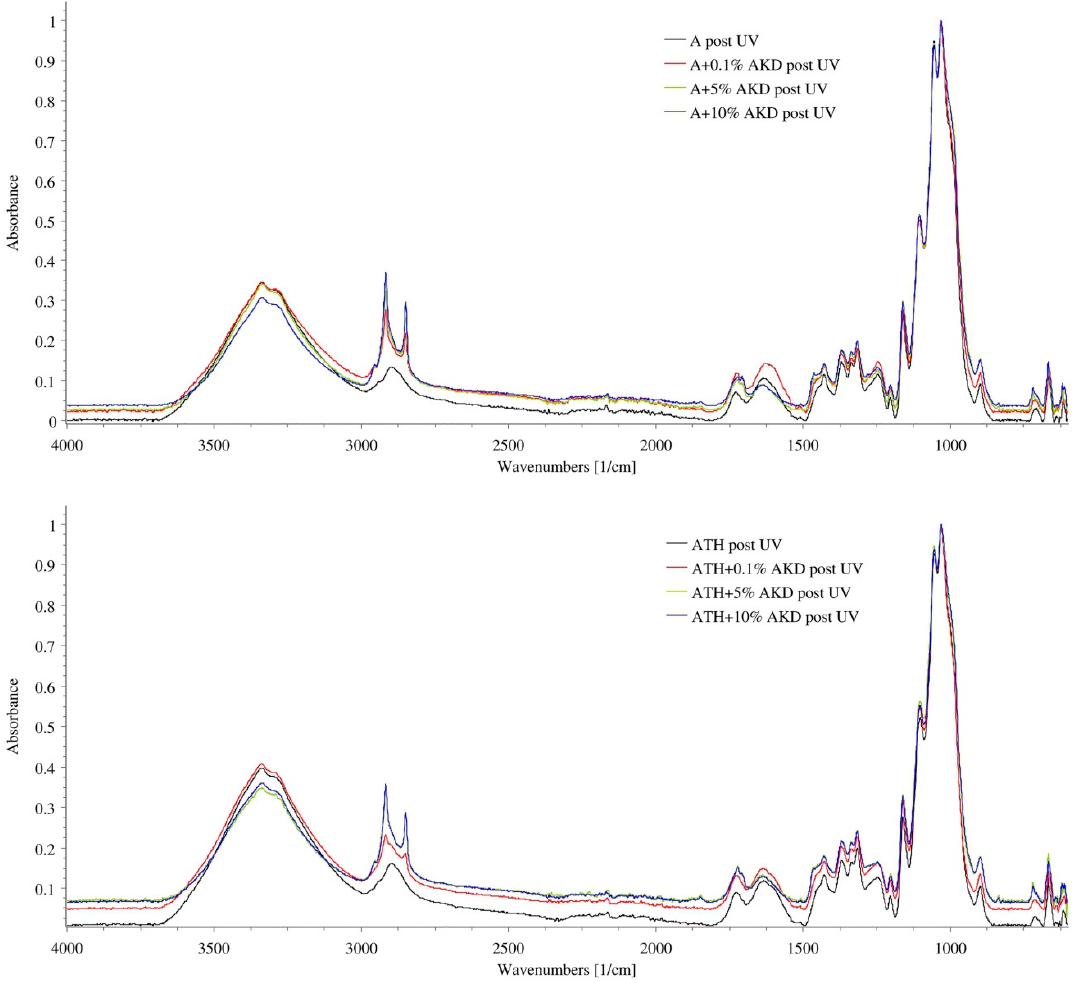
Figure 7. Comparison of FTIR spectra of A (top) and ATH (bottom) with AKD after UV exposure. The other relevant changes were displayed in the spectra: The bands ranging from 2850–2950 cm − 1 , which is typical of a AKD molecule; and the bands at approximately 1730 cm − 1 .